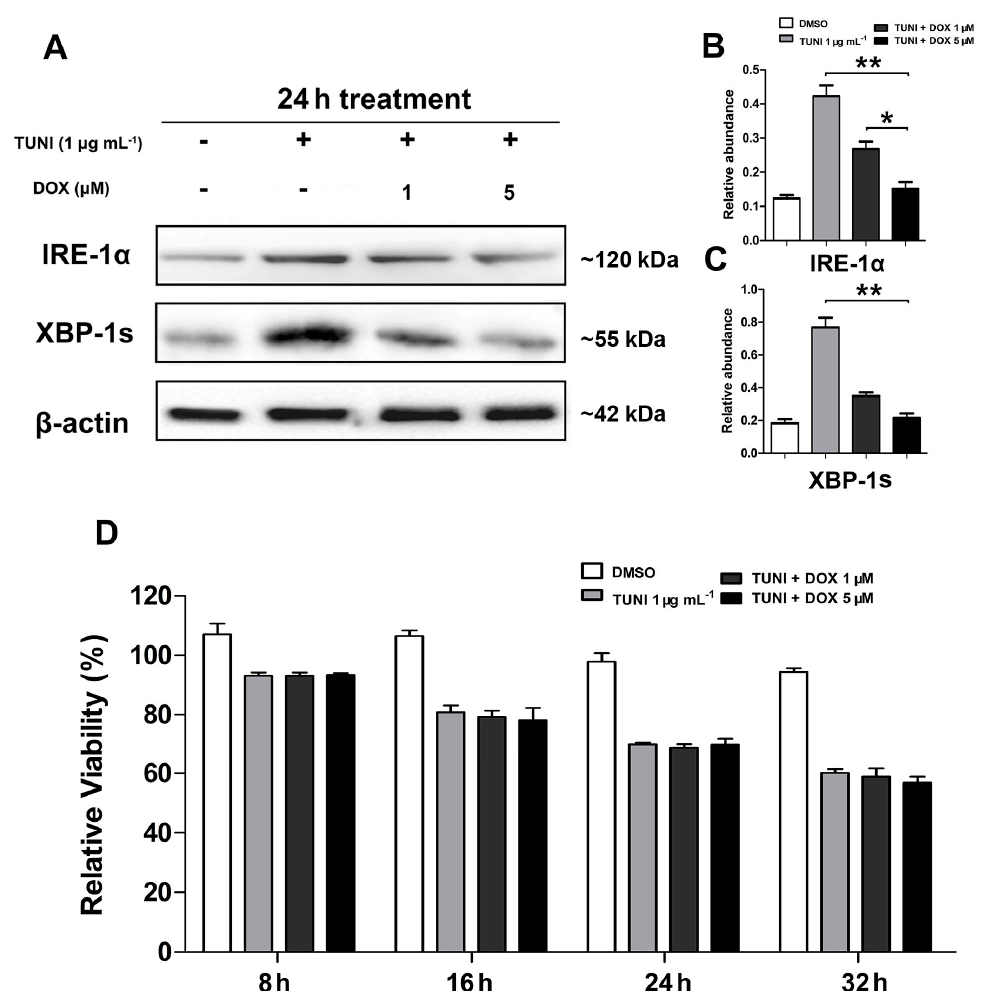
Figure 5. doxorubicin (DOX) inhibits activation of IRE-1 α and XBP-1. In basic DMEM, cells were treated with DMSO and 1.0 µ g mL − 1 TUNI or a combination of TUNI and DOX for 24 h. ( A ) Expression of IRE-1 α and XBP-1s proteins was determined using the Western blot; one representative protein band from the three independent experiments is shown; ( B ) Relative abundance of IRE-1 α ; ( C ) Relative abundance of XBP-1s; ( D ) Relative cell viability was measured using CCK-8 after the treatment. β -actin was assessed as a loading control. Data given as means ± SDs for the three independent experiments (* means under T test, p < 0.05, ** means under T test, p < 0.01).